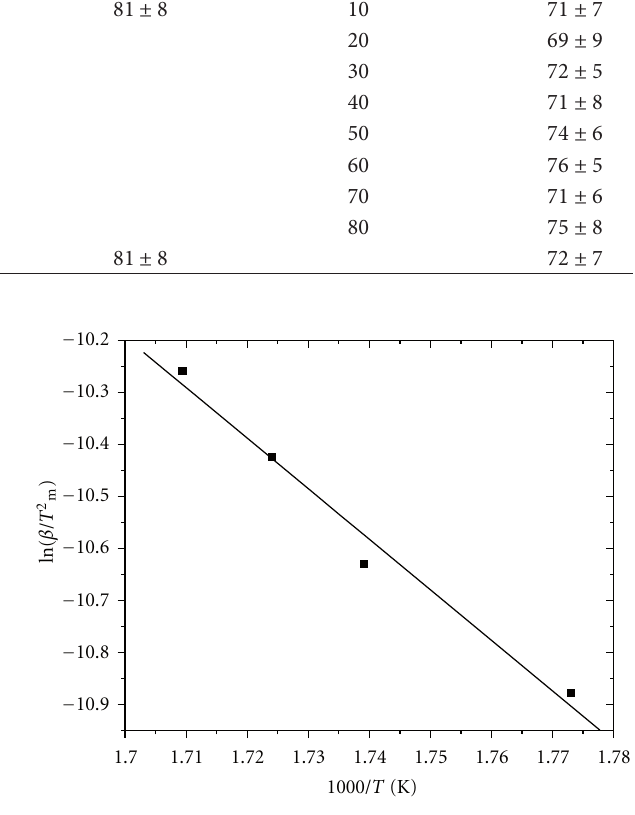
F 3: Kissinger plot of